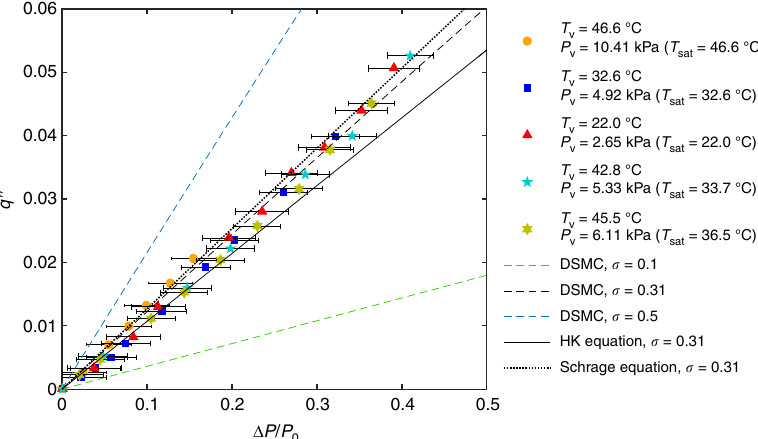
Fig. 5 Dimensionless interfacial fl ux q ̇̅ ″ as a function of the dimensionless driving potential Δ P/P 0 . The red triangles, dark blue squares, and orange circles represent the experimental data in saturated vapour for P v = 2.65 kPa with T v = T sat = 22.0 °C, P v = 4.92 kPa with T v = T sat = 32.6 °C, and P v = 10.41 kPa with T v = T sat = 46.6 °C, respectively. The light blue pentagrams are for T v = 42.8 °C, P v = 5.33 kPa with T sat = 33.7 °C and the yellow hexagrams are for T = 45.5 °C, P = 6.11 kPa with T = 36.5 °C. Note that the light blue pentagrams are also for a sample with a different porosity ( ≈ 0.23) and pore v v sat diameter ( ≈ 106 nm). The green dashed line, black dashed line, and blue dashed line are from the DSMC simulation with σ = 0.1, 0.31, and 0.5, respectively. The black solid line and black dotted line are from the HK equation and Schrage equation, respectively, both with σ = 0.31. The horizontal error bars originate from the uncertainties in temperature and pressure measurement (see Supplementary Notes 5 and 6). The error bars in q ̇̅ ″ are smaller than the